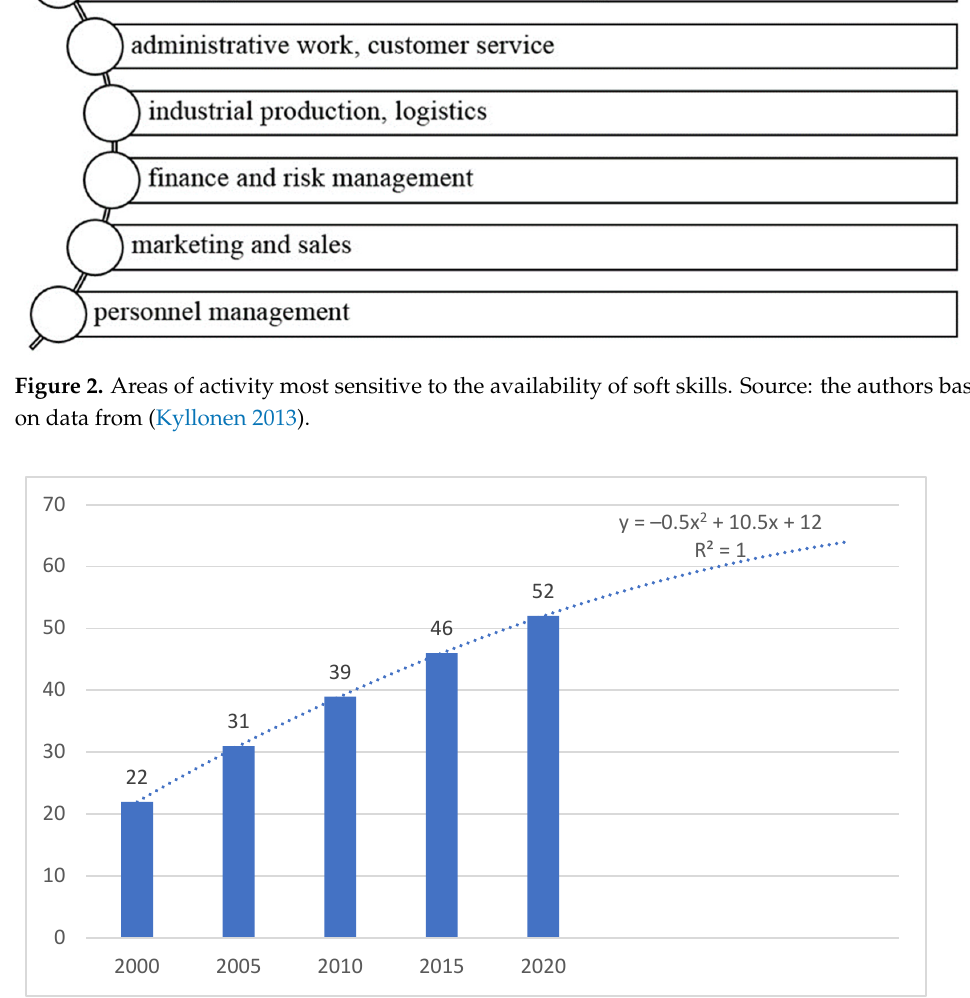
Figure 3. The forecast of the need for soft skills in the workplace. Source: the authors based on data from (Rasli et al. 2020).